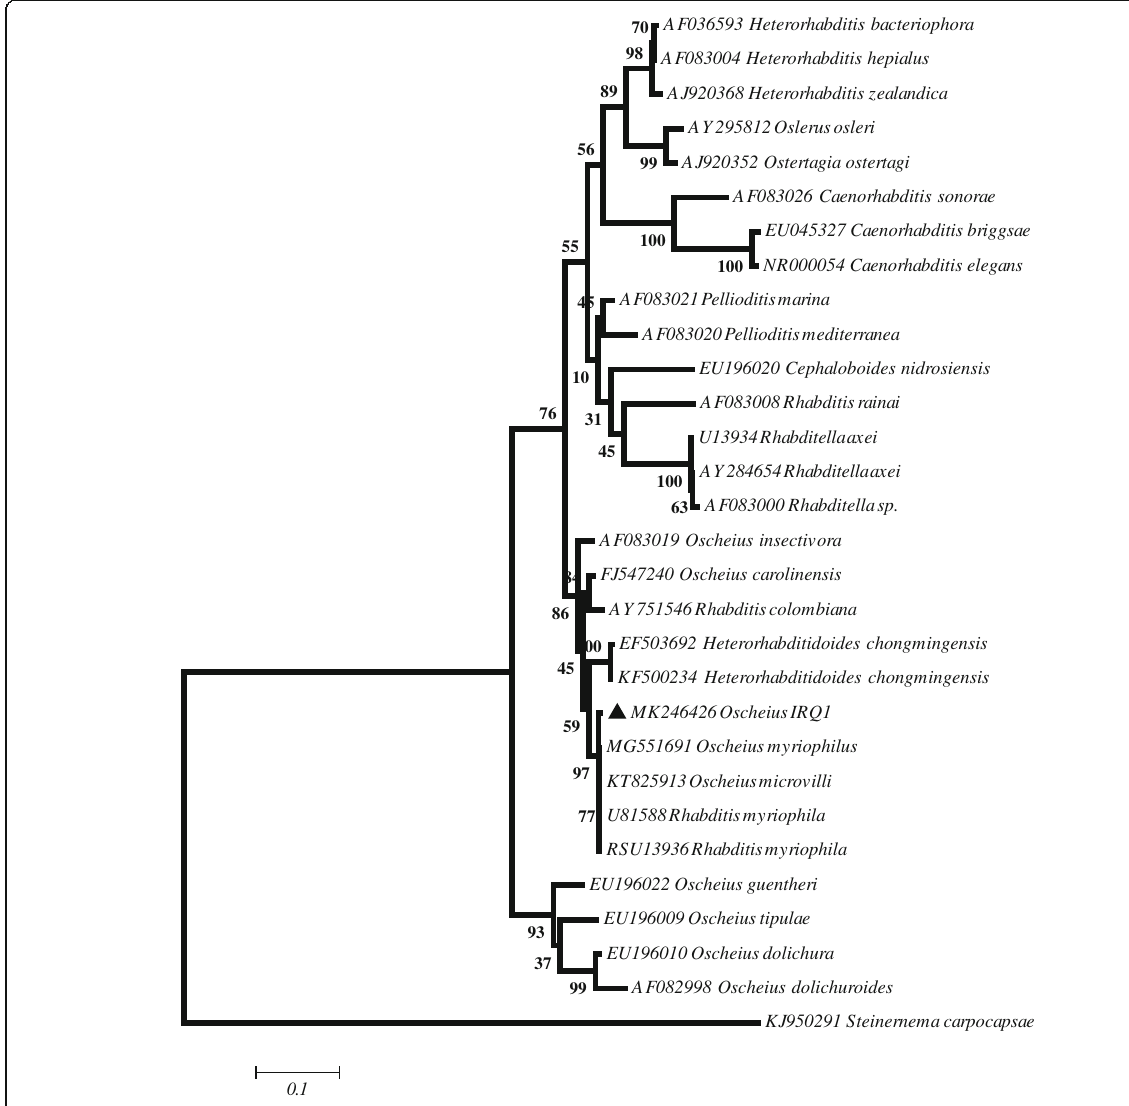
Fig. 4 Phylogenetic relationships of Oscheius isolates with 32 taxa based on 18S sequences as inferred from maximum likelihood (ML) analyses. Steinernema carpocapsae (accession number: KJ950291) was used as the outgroup. Support values are presented near the nodes in the form: bootstrap in